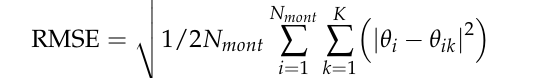
( b ) Figure 3. RMSE analysis: ( a ) RMSE in relation to snapshots; ( b ) RMSE in relation to SNR. As can be seen from Figure 3, the RMSE of these methods decreases as the SNR and the number of snapshots increase. As the number of snapshots and the SNR increase to a